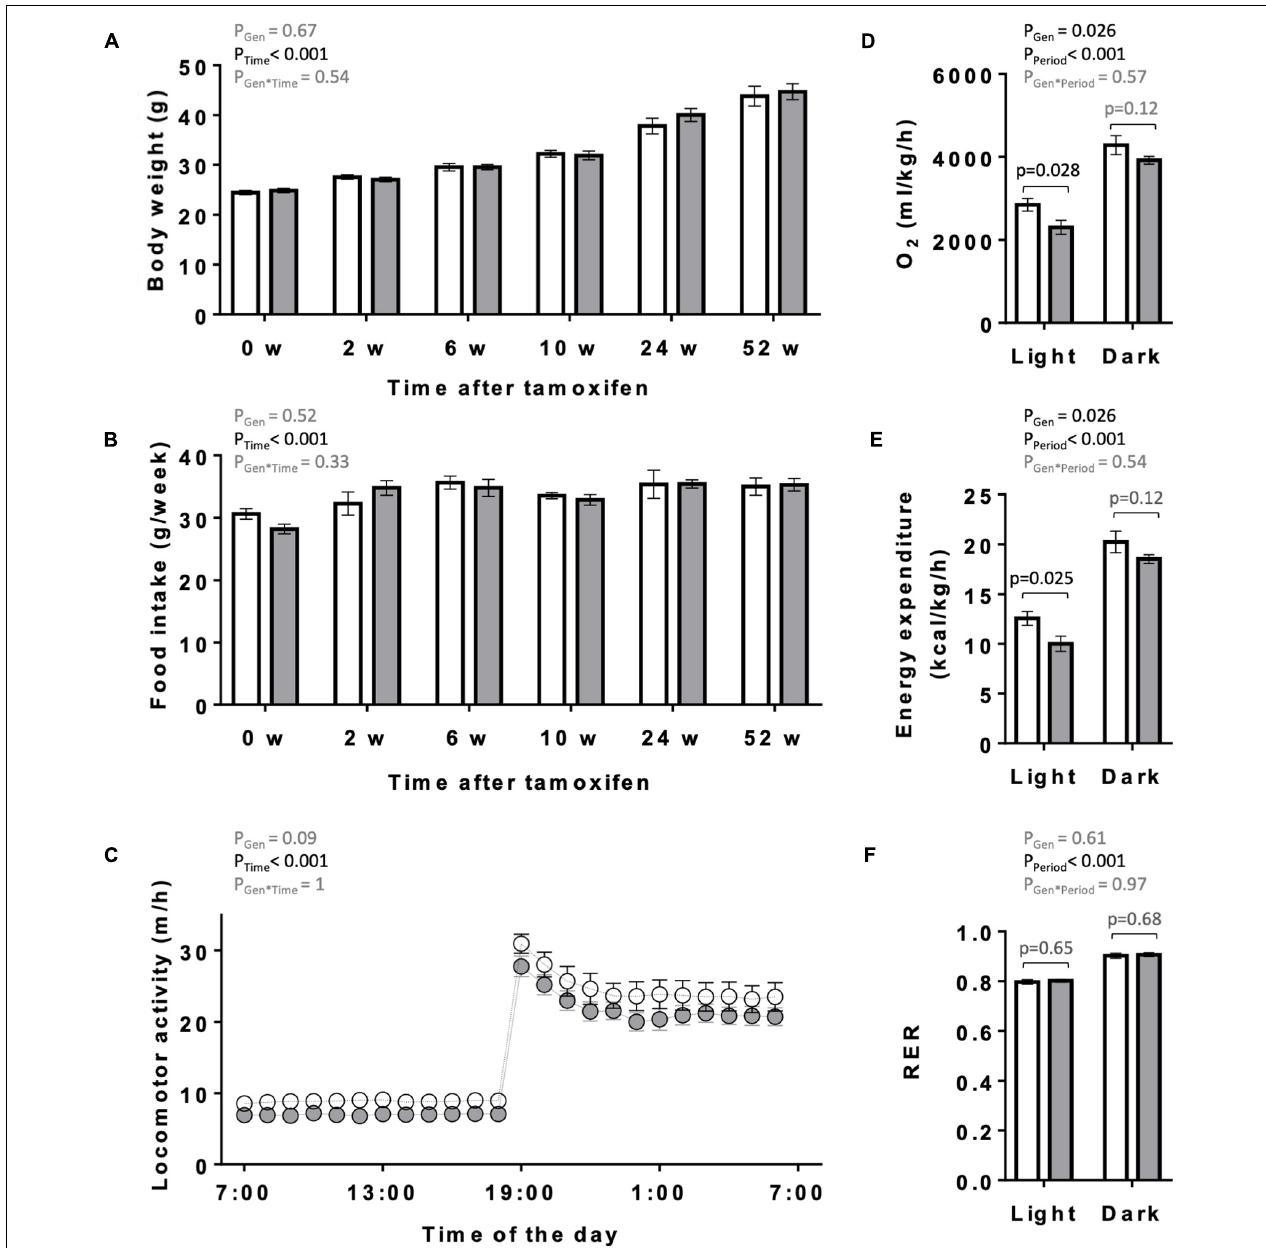
FIGURE 3 | Body weight, food intake, locomotor and metabolic activity in control and AMPK α 1 α 2-KO mice. (A,B) Body weight (A) and food intake (B) of mice of the both genotypes on the day of the first tamoxifen injection and then 2, 6, 10, 24, and 52 weeks after tamoxifen administration. (C) Diurnal locomotor activity of control and AMPK α 1 α 2-KO mice 12 months after tamoxifen administration. (D–F) Metabolic activity of control and AMPK α 1 α 2-KO mice 12 months after tamoxifen administration: oxygen consumption (D) , energy expenditure (E) and respiratory exchange ratio (RER, F ). Control (white bar and symbols), KO (gray bar and symbols). Data are given as means ± SEM; n = 13 control and 17 KO (A,B) , 5 control and 9 KO (C–F) . Data were analyzed by 2-way Repeated Measure ANOVA (A–F) followed in panel (D–F) by Student–Newman–Keuls test for pairwise comparisons. Resulting significance values are given for two main effects related either to genotype P Gen , time P Time , and their interaction P Gen × Time (A–C) or to genotype P Gen , light/dark period P Period , and their interaction P Gen × Period (D–F) ; in panel (D–F) significance values, p , of pairwise comparisons between two genotypes are given for light and dark periods. For more details see section “Materials and